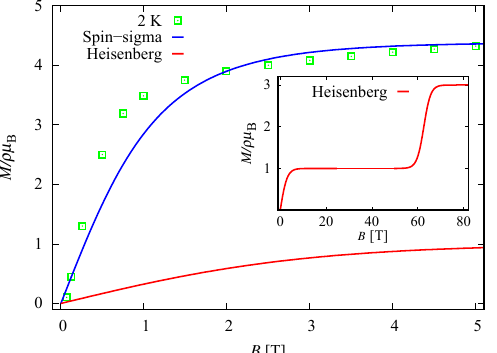
Figure 5. Non-dimensional magnetization of the complex Na 9 [Er(W 5 O 18 ) 2 ] as a function of dc magnetic field at 2 K and b = 0 T. Here, ρ and µ B denote the number of isolated polyanions per unit volume and Bohr magneton, respectively. The experimental data, the green squares, are provided in Reference [9]. The solid blue and red lines represent the calculated magnetization obtained, respectively, by using Hamiltonian (1) and the Heisenberg model (3). The inset shows a saturation of magnetization with values above 70 T predicted from the Heisenberg